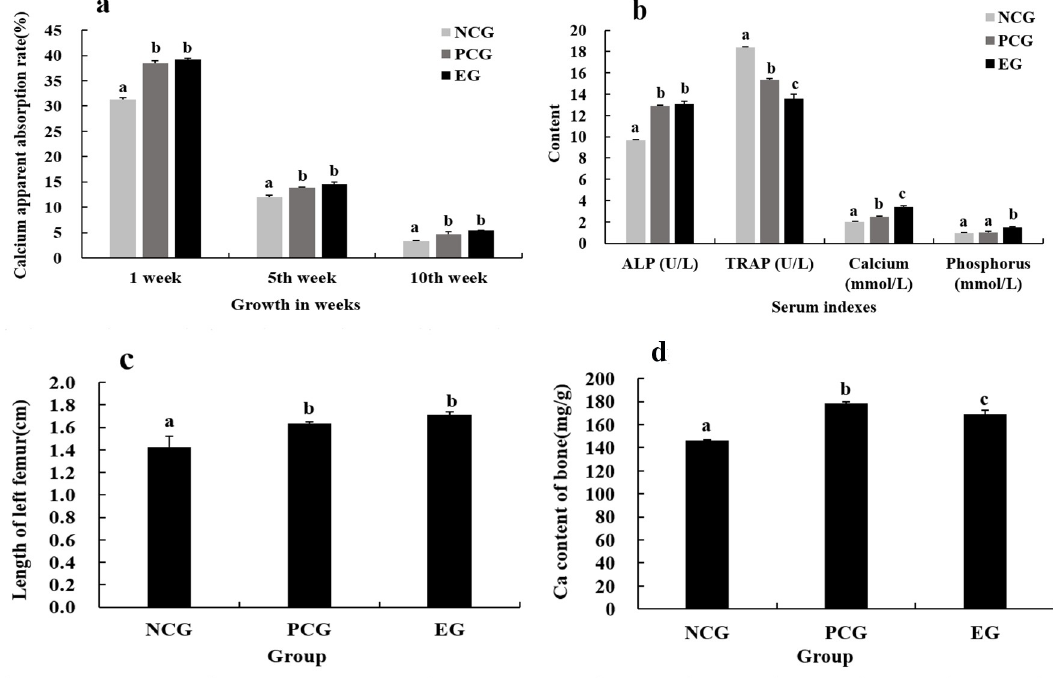
Fig 4. Evaluation of the effects of calcium supplementation with bovine bone calcium malate. (a) effect of different calcium sources on apparent absorption of calcium in rats; (b) effects of different calcium sources on serum indexes in rats; (c) & (d) effects of different calcium sources on femoral length and bone calcium levels in rats. Values for the same component were significantly different (p < 0.05).